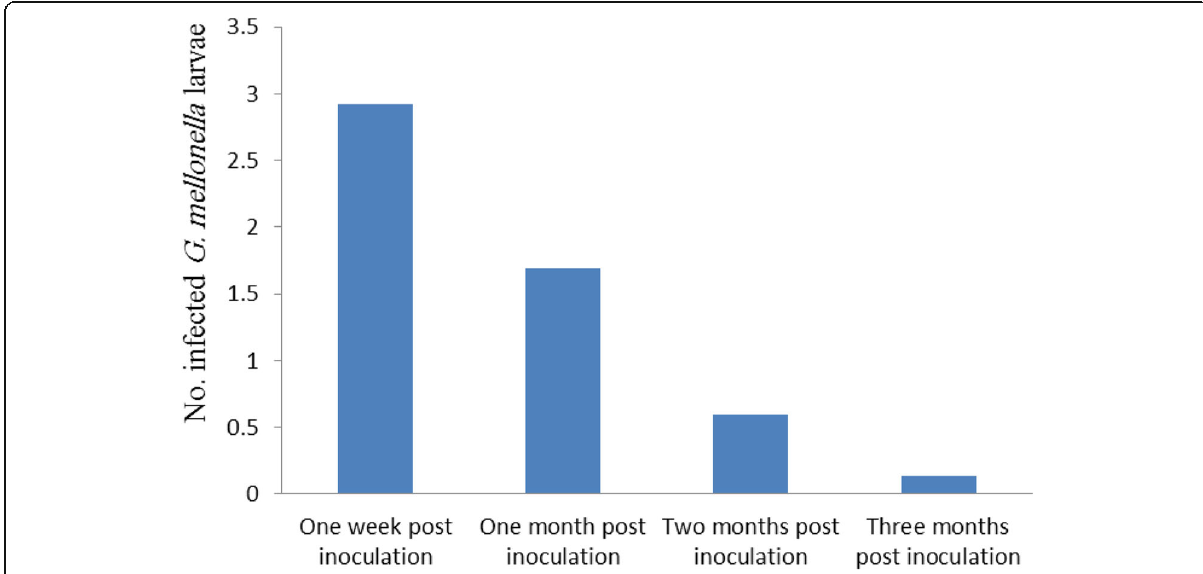
Fig. 4 Average mortality out of four Galleria mellonella larvae exposed to 38 Heterorhabditids indica populations in soil at increased post- nematode inoculation periods. Numbers among all post-inoculation days are significantly ( P ≤ 0.05) different according to